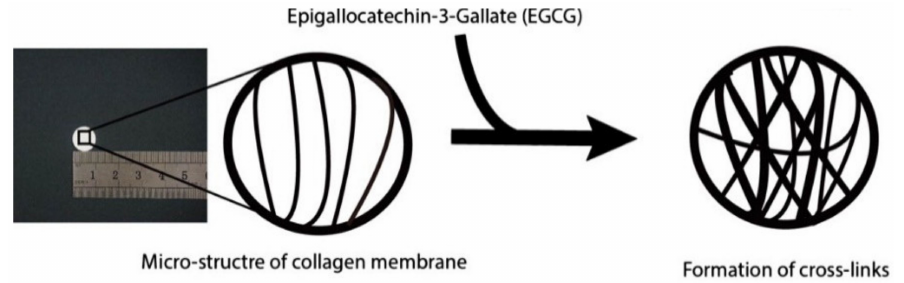
Figure 12. Cross-linking reaction of a collagen membrane using epigallocatechin gallate [184]. Repro- duced with permission from Elsevier